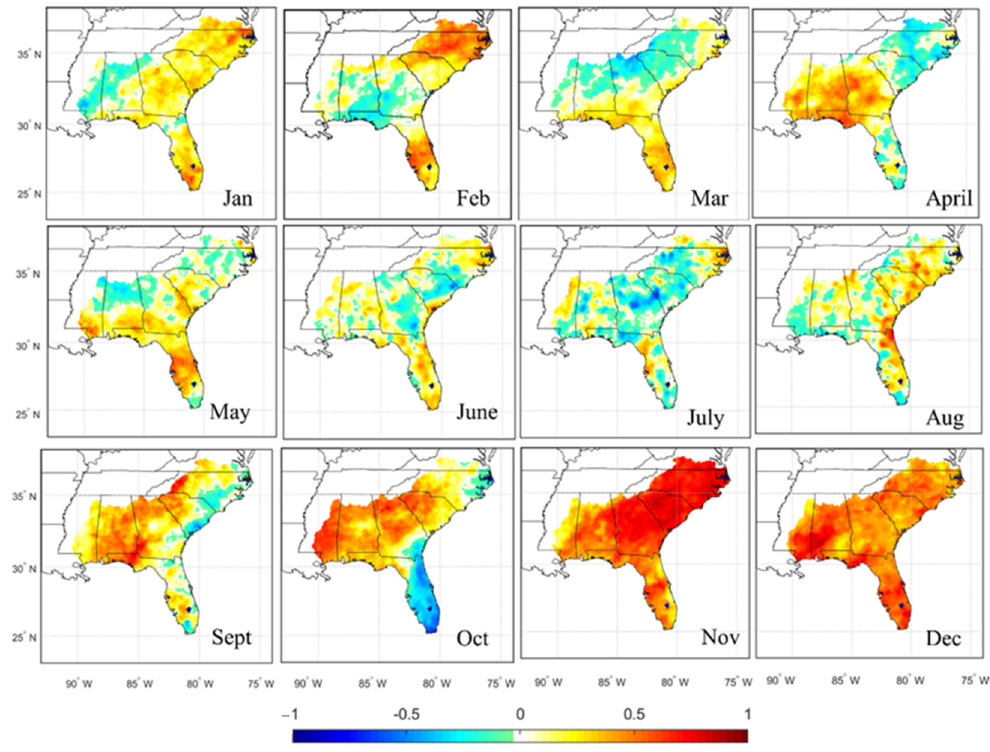
Figure 4 . Spatiotemporal correlation maps between precipitation and ENSO. Figure 4. Spatiotemporal correlation maps between precipitation and